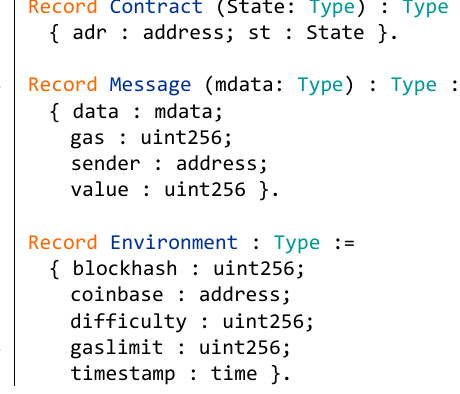
Figure 10. Structural model of message